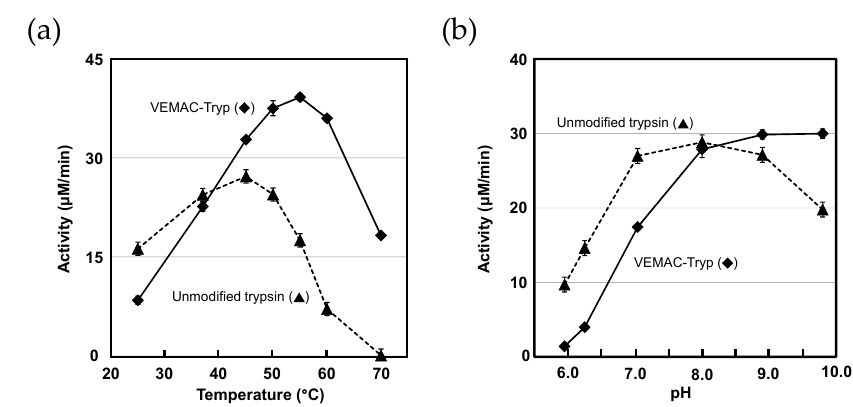
Figure 3. ( a ) Temperature dependence of the enzymatic activity of unmodified trypsin and vinylmethylether-maleic acid copolymer (VEMAC)-Tryp (measured at pH 8.0); ( b ) pH dependence of the enzymatic activity of unmodified trypsin and VEMAC-Tryp (measured at 37 ◦ C). Data are shown as mean ± SD ( n = 3).